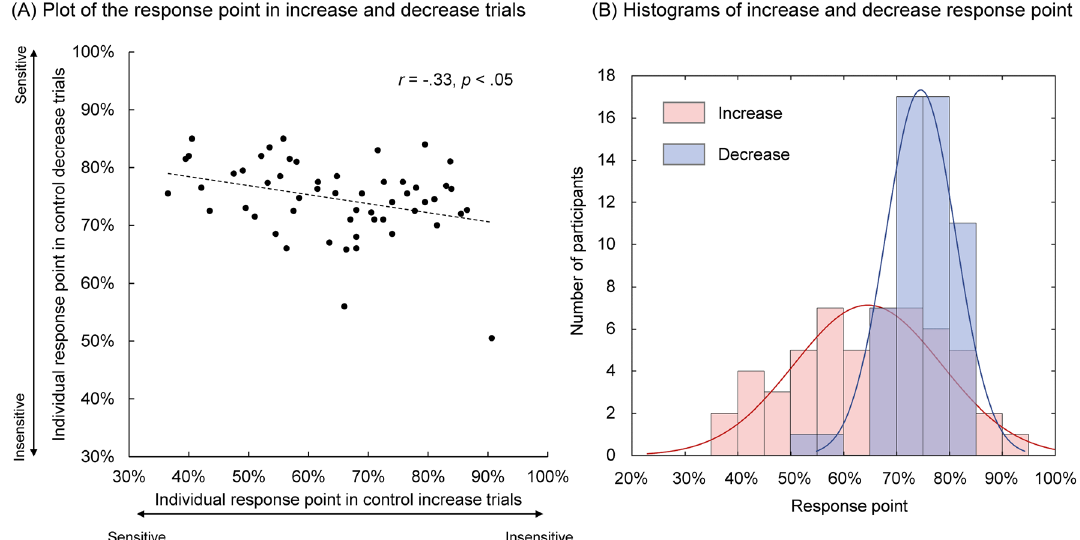
Figure 2. The individual response point in each block ( A ) and the histograms of increase and decrease response points ( B ). The correlation between the perceptual sensitivity to control increase and that to control decrease was significant ( r = − 0.33, n = 54, p < 0.05). The dashed line in ( A ) shows the linear regression line. The solid curves in ( B ) show the fit curves of normal